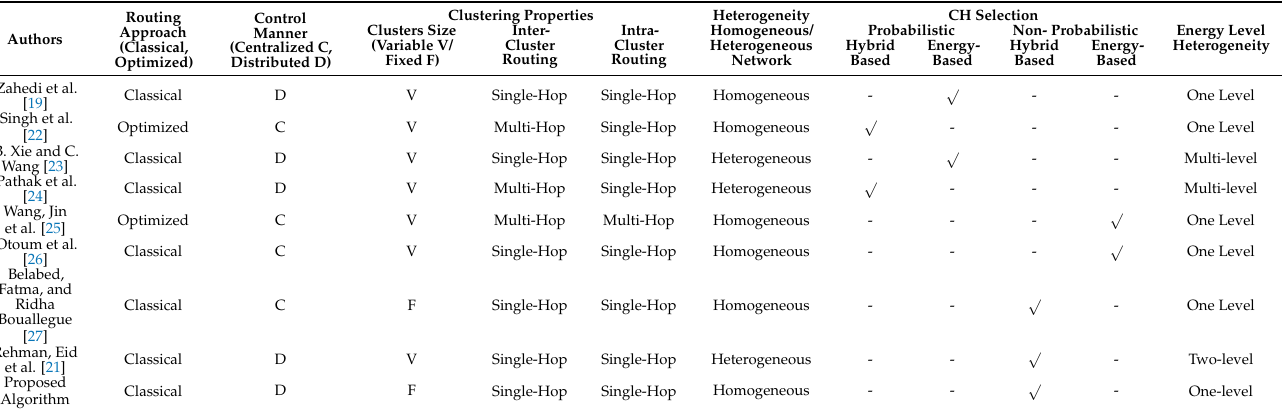
Table 1. Comparison of clustering